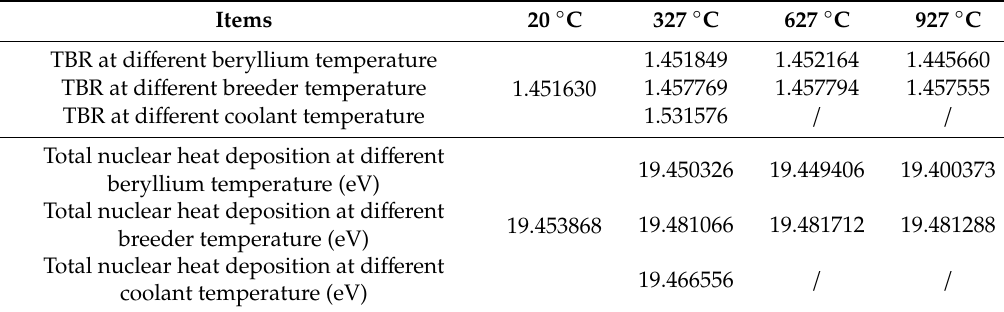
Table 11. Neutronics results of the WCCB blanket at di ff erent materials temperatures.